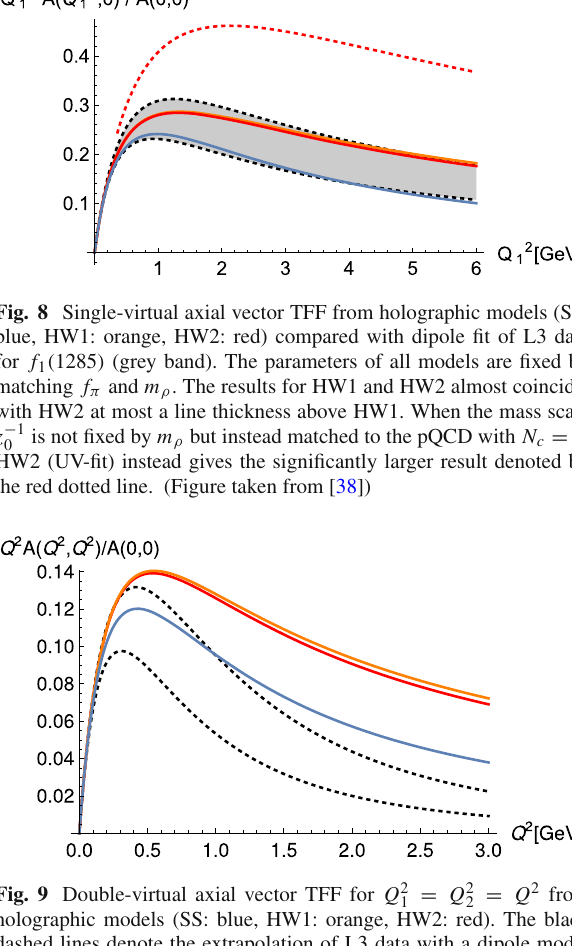
Fig. 9 Double-virtual axial vector TFF for Q 2 holographic models (SS: blue, HW1: orange, HW2: red). The black dashed lines denote the extrapolation of L3 data with a dipole model for each virtuality as used in the calculation of a f 1 μ in Ref. [15]. (Figure taken from [38])